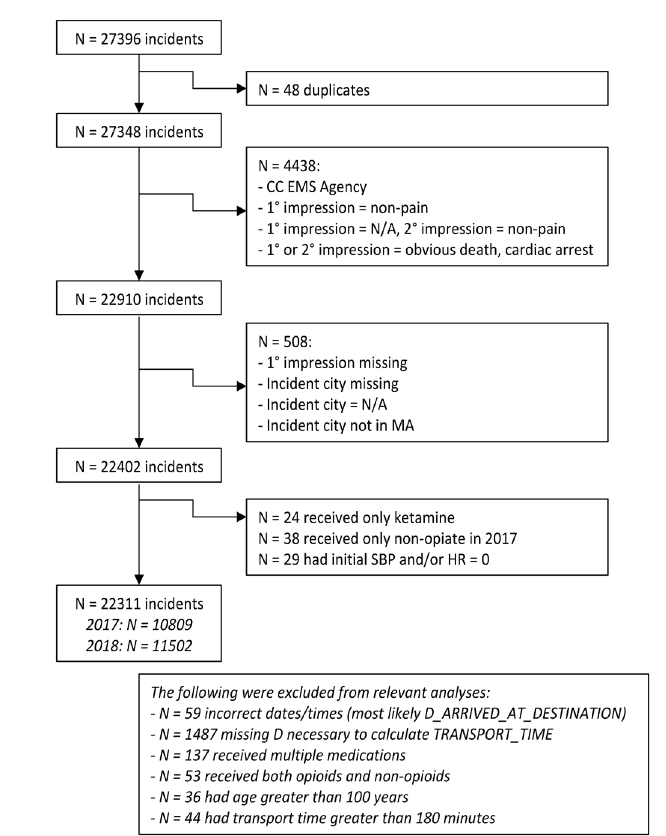
Figure. Inclusion decision-making parameters for paramedic administration of opiate and non-opiate medications. EMS, emergency medical services; SBP, systolic blood pressure; HR, heart